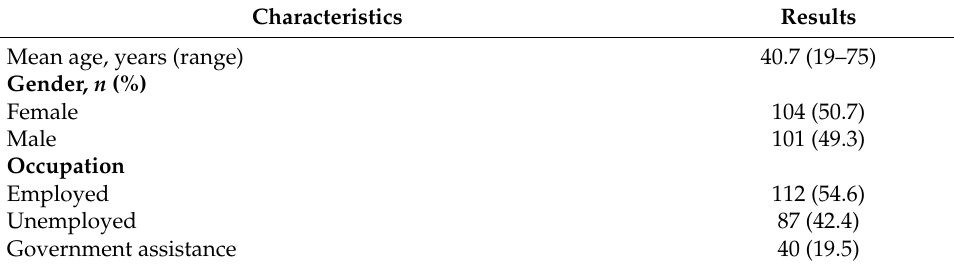
Table 1. Baseline clinical and demographic characteristics of 205 patients.